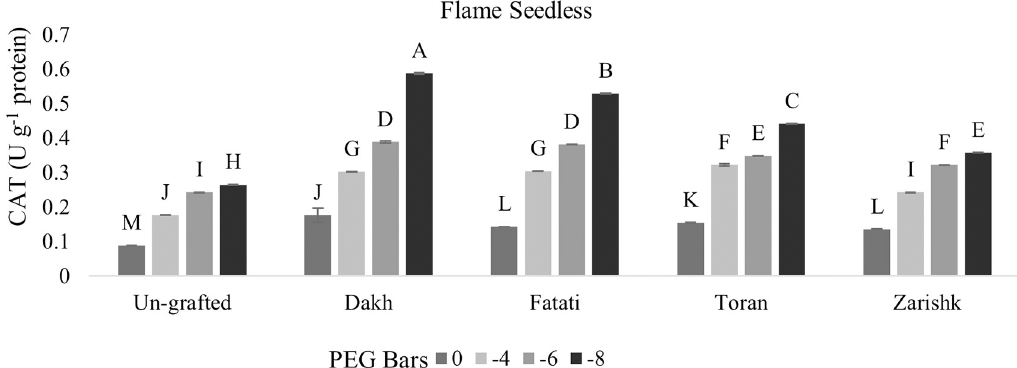
Fig 12. Catalase (CAT) enzymatic activity of un-grafted and grafted Flame Seedless scion variety grafted on different wild grapevines under drought stress condition. Data is represented as mean SD and letters showed significant difference at p <